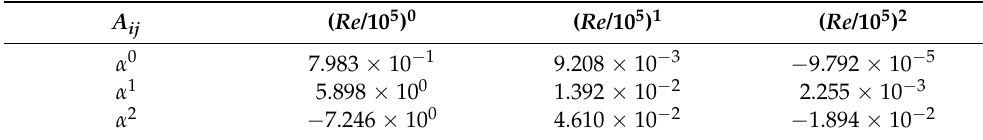
Table 1. Value of coefficient A ij .